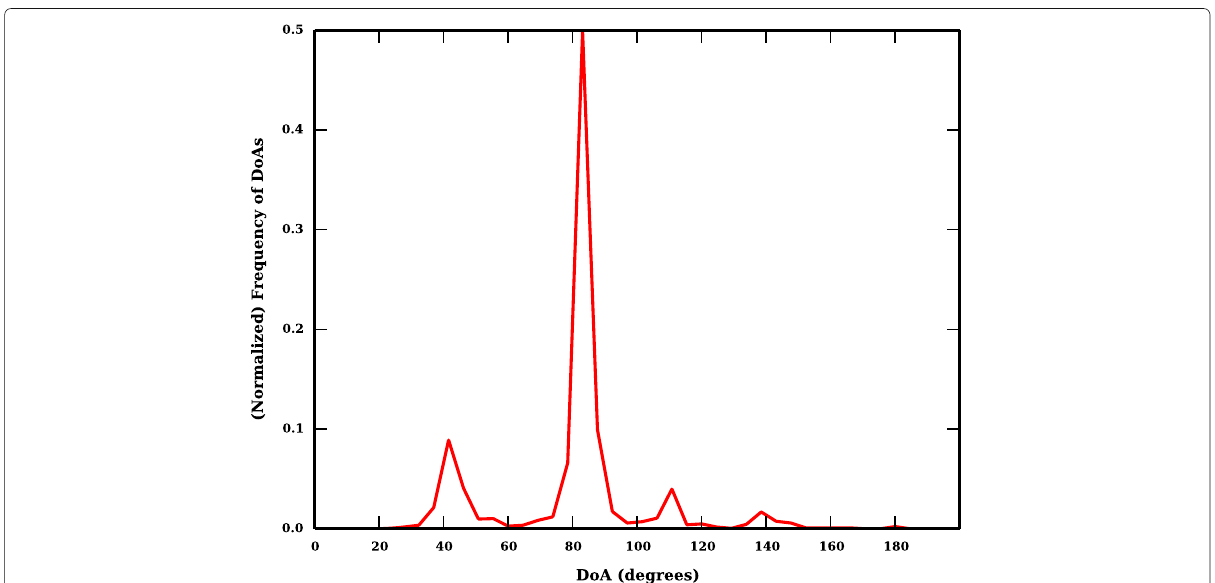
Fig. 11 Histogram of DoA estimates obtained by SRP-NMF on recording2 ( Task2 ) from LOCATA1 containing four concurrent speakers